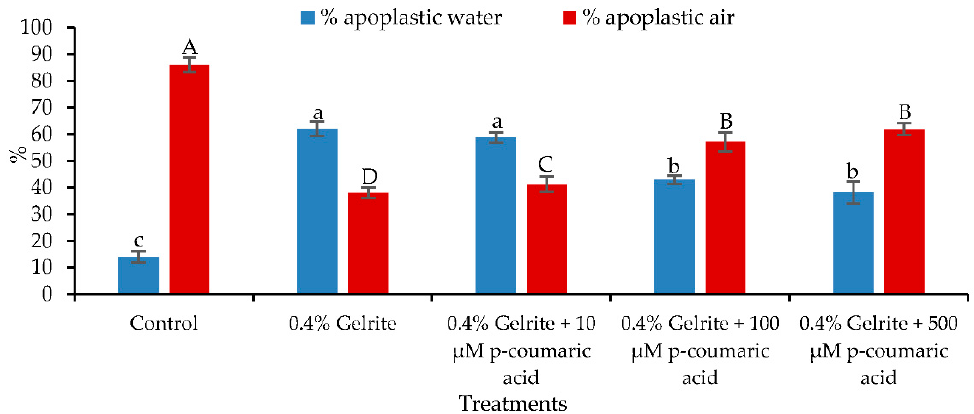
Figure 3. The percentages of apoplastic water and air related to the total volume of the apoplast in Arabidopsis thaliana (Col-0) seedlings after 14 days of culture on different concentrations of p -coumaric acid. Different letters indicate significant differences between means at α = 0.05 level.